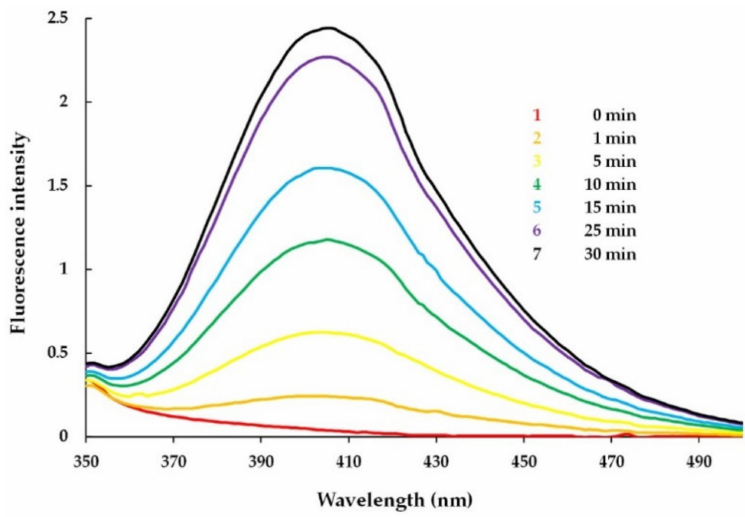
Figure 3. Fluorescence spectra of dityrosine formed during incubation of Hm-AMP2 (40 µ M) with MPO (0.4 µ M heme) activated by 50 µ M H 2 O 2 in 10 mM Na-phosphate buffer, pH 7.4. Spectra ( λ ex = 315 nm) were taken before (0 min, red line) and after adding H 2 O 2 at time intervals indicated in the